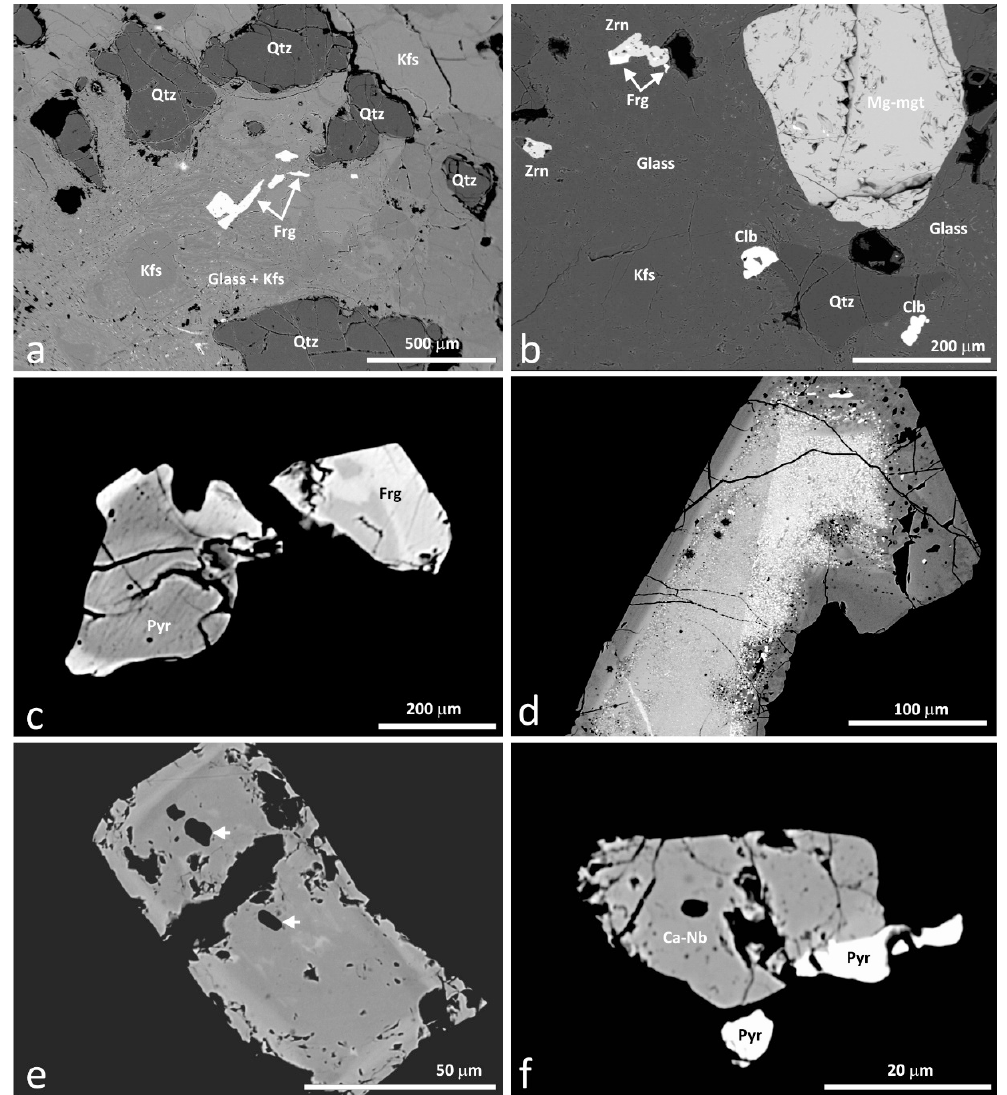
Figure 3. Back-scattered electron (BSE) images of high-field-strength elements (HFSE)-bearing minerals in granite xenoliths. ( a ) Fergusonite (Frg) cluster in the interstitial glass. Qtz and Kfs denote quartz and potassium feldspar, respectively. Sample Ca10. ( b ) Magnetite phenocryst with increased Mg content (Mg-mgt) associated with zircon (Zrn) and columbite (Clb). Fergusonite (Frg) sticks to zircon grains with uranothorite inclusions. Sample Ca3. ( c ) Complex domain zoning of pyrochlore and fergusonite caused by variable Ti, Nb and U contents. Sample Ca3. ( d ) Sector-zoned zircon with an inclusion-free rim around the core overcrowded with tiny uranothorite inclusions. Isolated bright spots in the rim are pyrochlore inclusions. ( e ) Oscillatory growth zoning of fergusonite crystal with two silicate glass inclusions indicated by white arrows. Sample Ca3. ( f ) Ca-niobate (Ca–Nb) associated with pyrochlore (Pyr). Sample